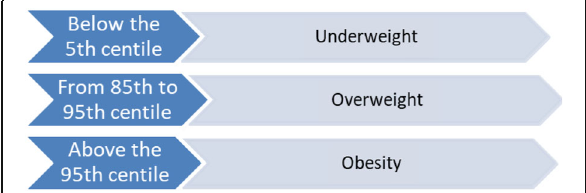
Fig. 2 Manner of specifying the nutritional status of